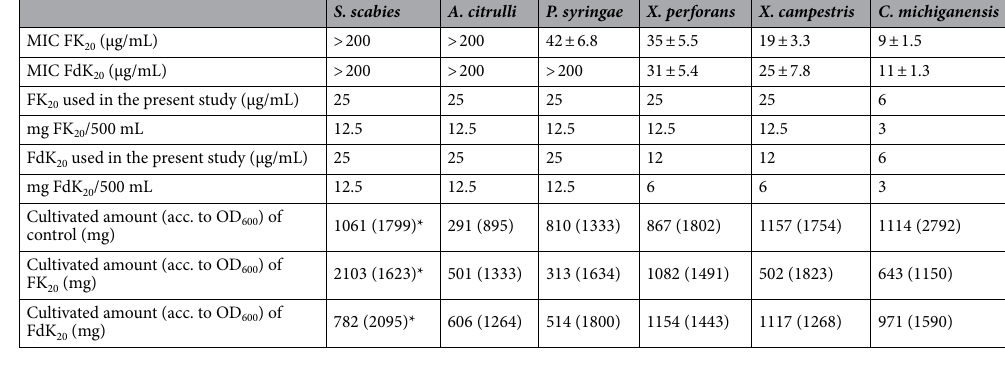
Table 2. Minimal inhibitory concentrations (MICs) (mean values and standard error) of FK 20 and FdK 20 towards tested bacteria after 24 h incubation (data from Topman et al. 9 ), the used concentration of FK 20 and FdK 20 and the cultivated amount of control, FK 20 - and FdK 20 -treated bacteria samples. With S. scabies = Streptomyces scabies, X. campestris = Xanthomonas campestris pv. campestris, X. perforans = Xanthomonas perforans, C. michiganensis = Clavibacter michiganensis, P. syringae = Pseudomonas syringae pv. tomato, A. citrulli = Acidovorax citrulli. *In brackets the cultivated amount of freeze-dried supernatant was